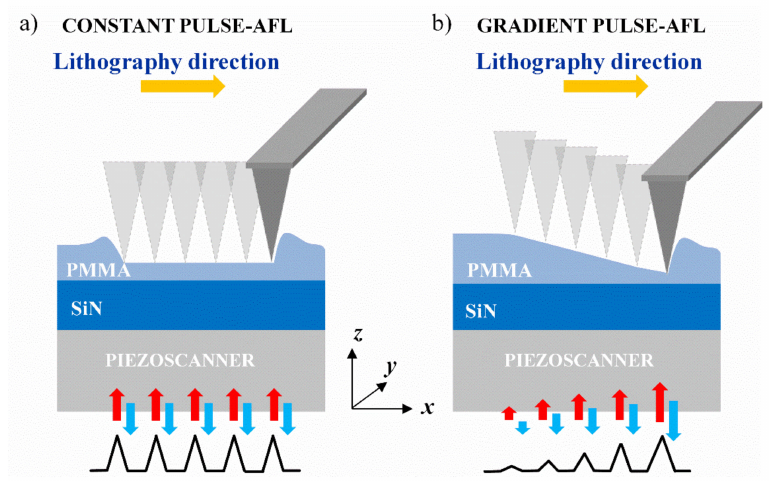
Figure 1. Schematic diagram of ( a ) Constant Pulse- and ( b ) Gradient Pulse- Atomic Force Lithography techniques performed on a thin PMMA layer. The yellow arrow indicates the nanolithography direction, while the red and blue arrows the movement of the piezo-scanner in the z direction, induced by the voltage